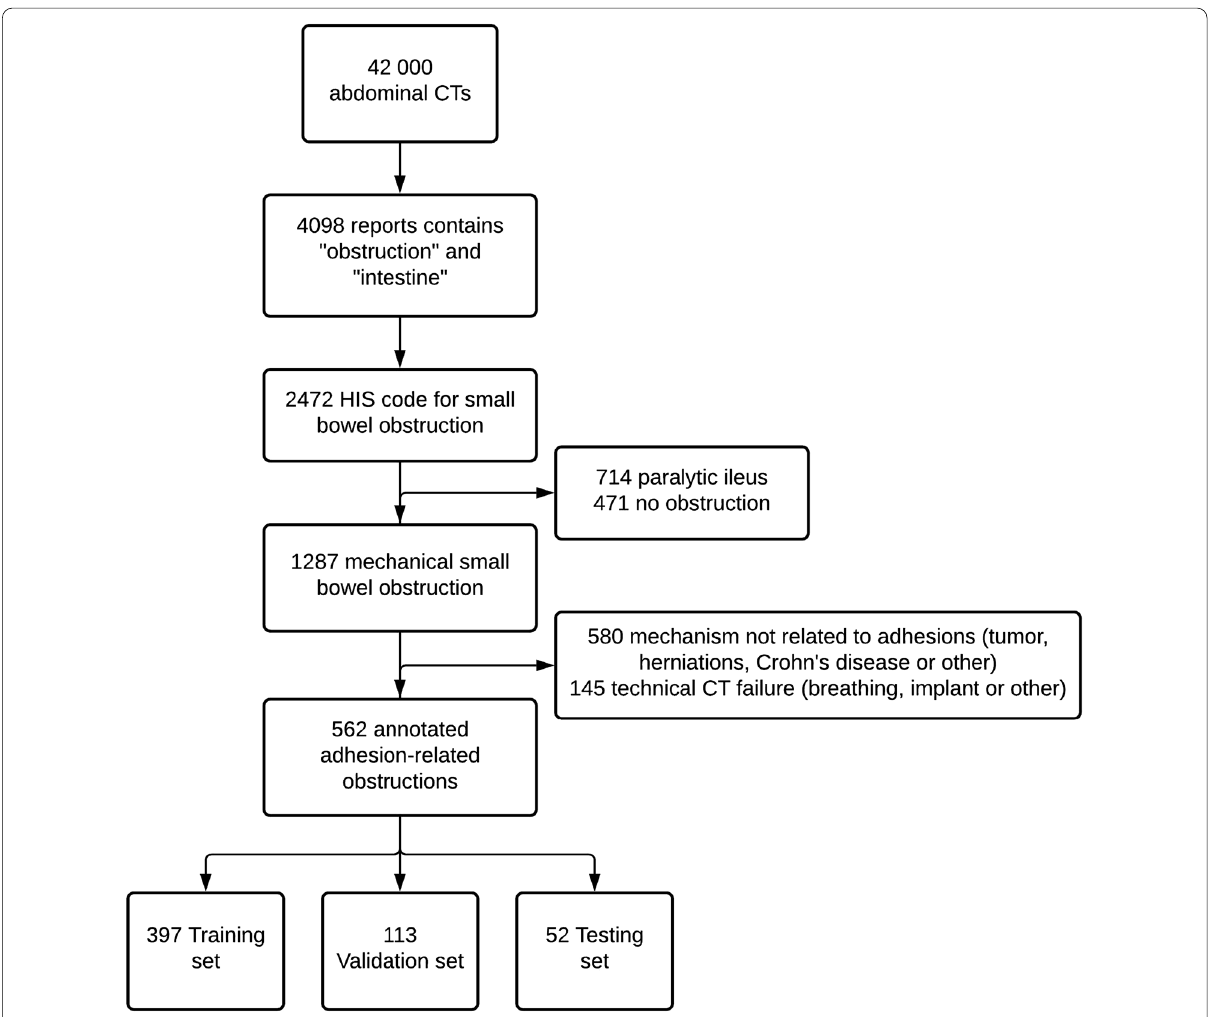
Fig. 1 Flow chart of the data selection process. HIS: health information